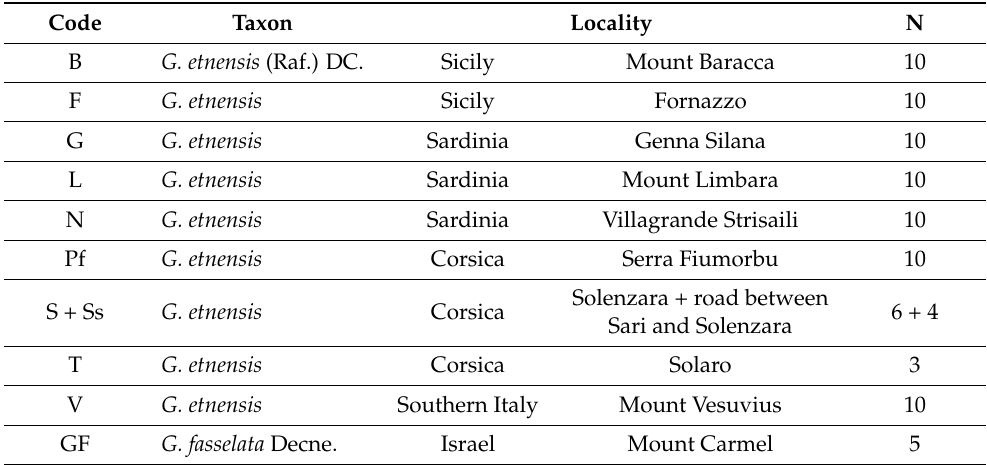
Table 1. Investigated samples of Genista etnensis and the